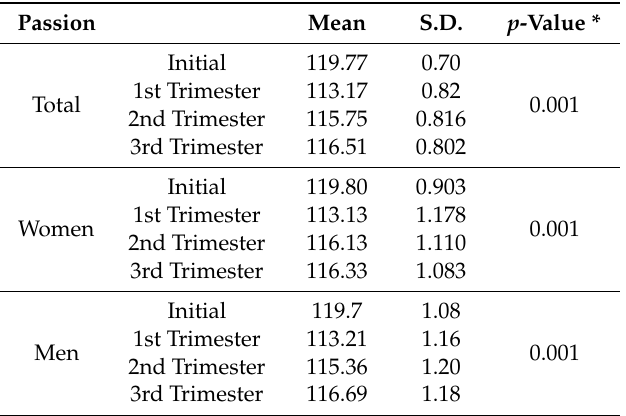
Table 10. Initial and final passion means for each trimester.